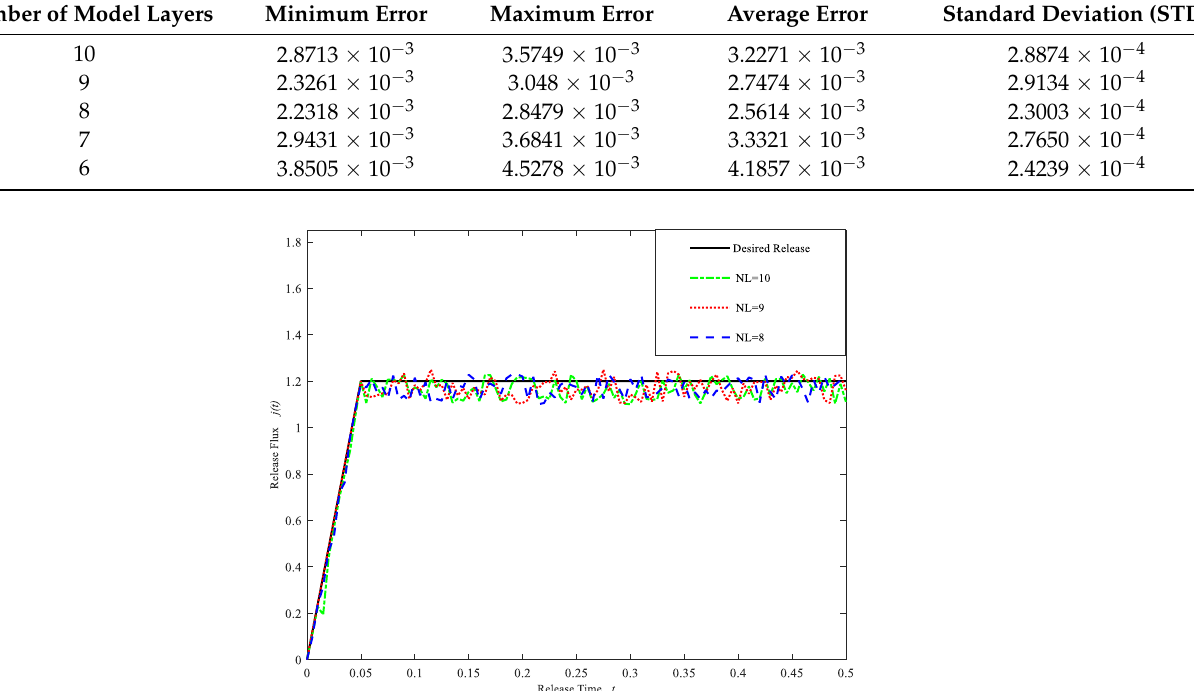
Table 11. Statistical analysis of the error for optimization of the initial drug concentration and diffusion coefficient (Case 3).